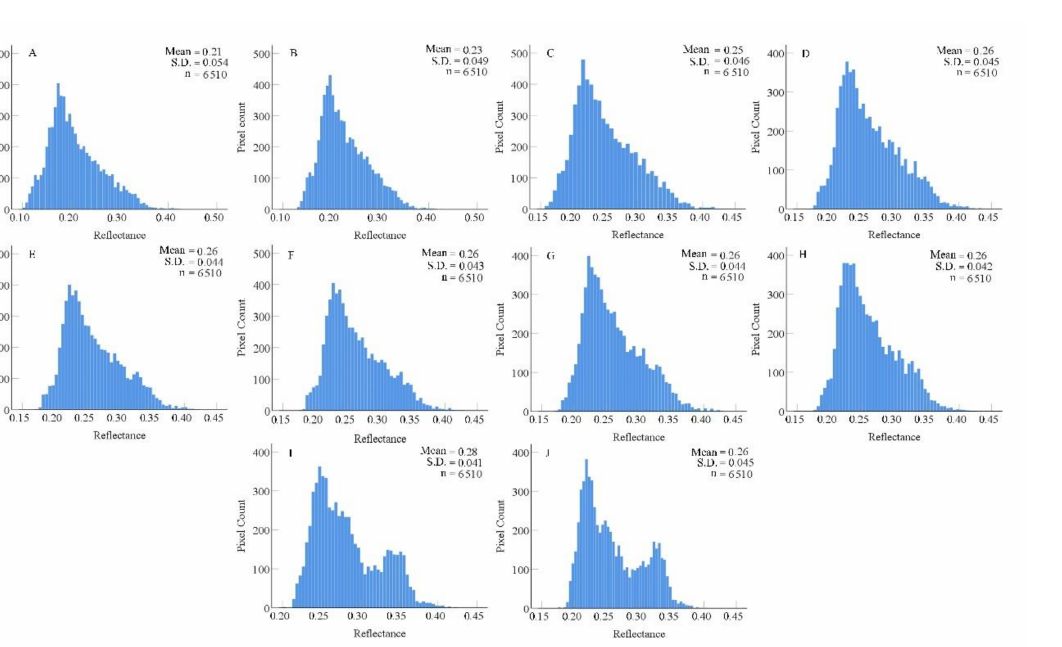
Figure 2. Pixel count statistics of 6510 random soil pixels in the Sentinel-2 MSI spectral band. ( A ) Band 2-Blue; ( B ) band 3-Green; ( C ) band 4-Red; ( D ) band 5-Rededge1; ( E ) band 6-Rededge2; ( F ) band 7-Rededge3; ( G ) band 8-NIR; ( H ) band 8a-red edge4; ( I ) band 11-SWIR; ( J ) band